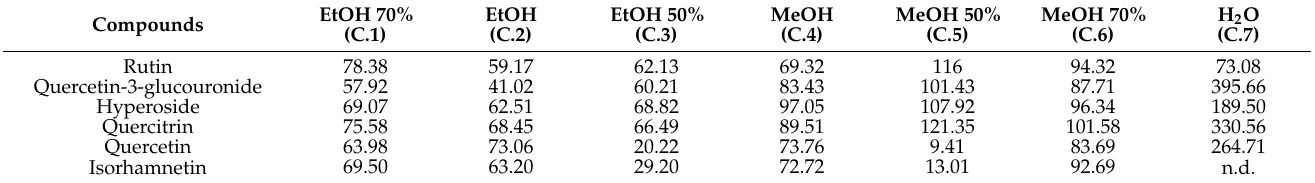
Table 6. Recovery percentages ( n = 2) for extraction without hydrolysis at Temp. 25 ◦